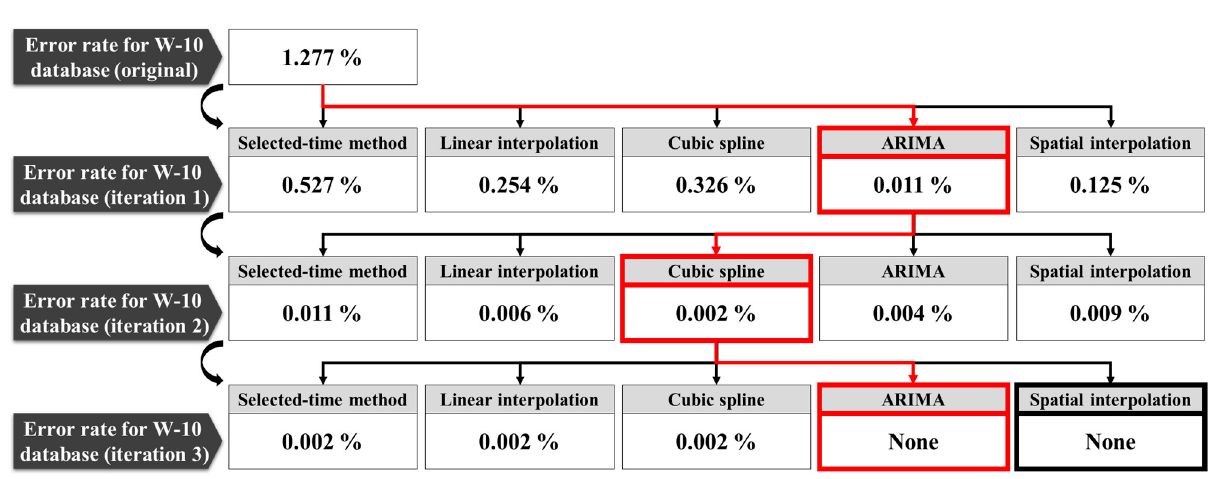
Figure 11. Improvement of data quality through the iterative quality control process for W-10 water level data.